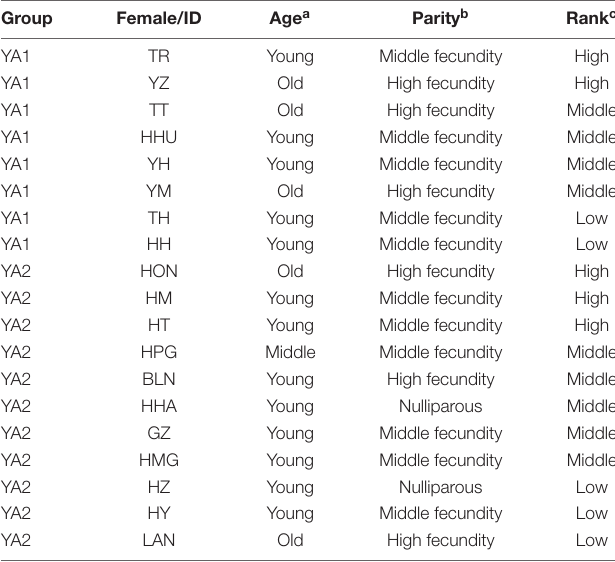
TABLE 2 | Female social ranks in group YA1/YA2 during the study